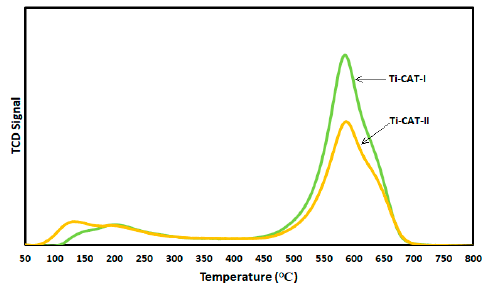
Figure 5. TPO profiles for both Ti-CAT-I and Ti-CAT-II.